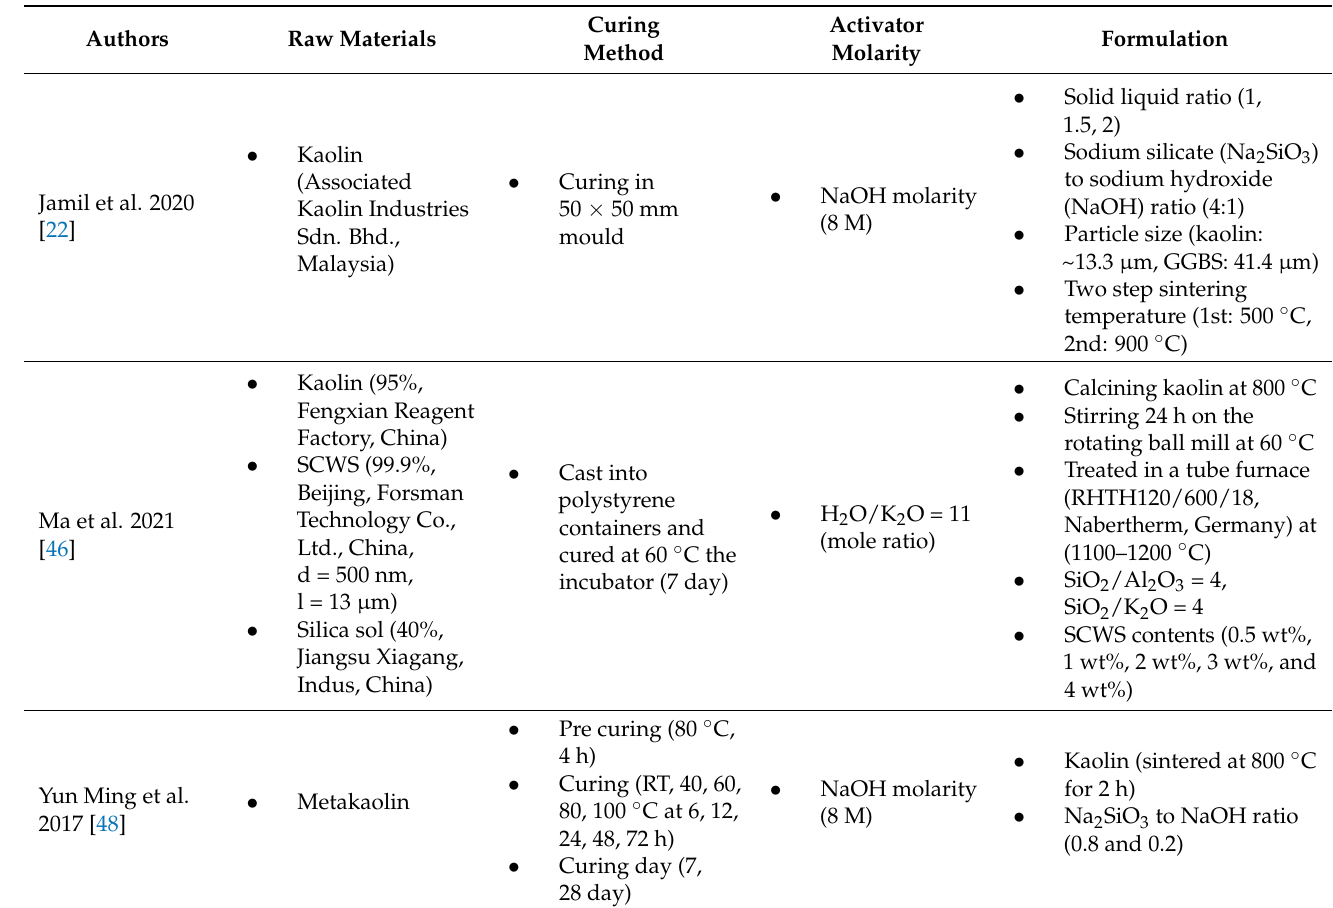
Table 1. Mix design of geopolymer materials in ceramic